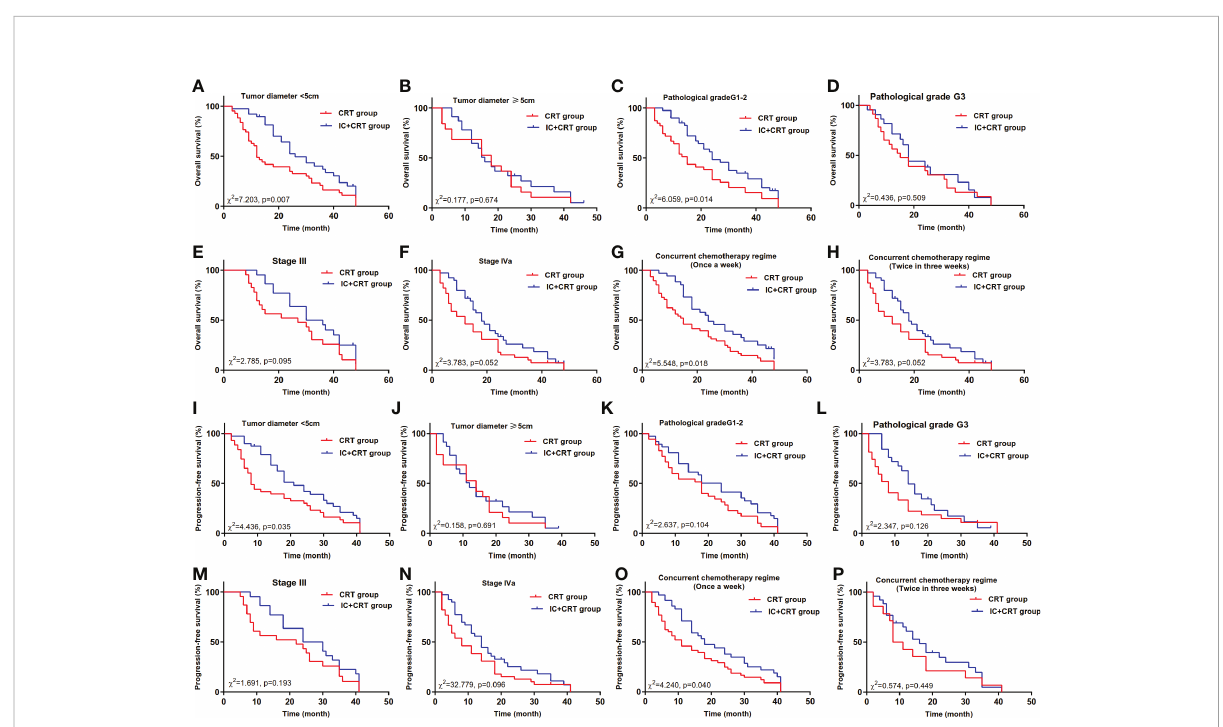
FIGURE 2 Overall survival and progression-free survival between IC+CRT group and CRT group. (A – H) : Overall survival in different subgroups; (I – P) : progression-free survival in different